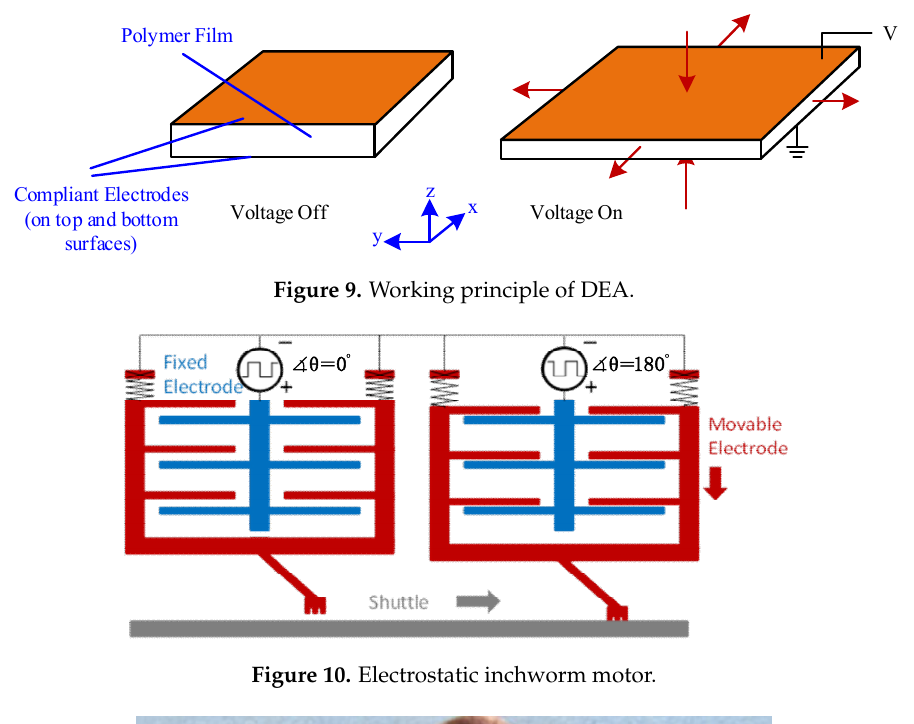
Figure 10. Electrostatic inchworm motor.